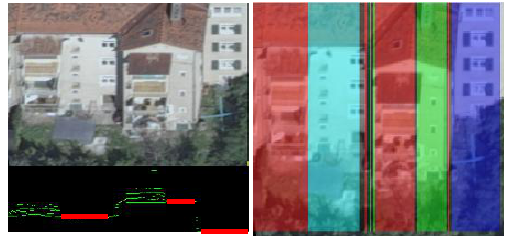
Figure 7: Plane detection for a complex facade; (a) key-view of a facade and projection in xy-plane (red lines are strongly weighted (>66% of points lie in this plane); (b) determined major facade planes (segmented areas with balconies are marked in red)